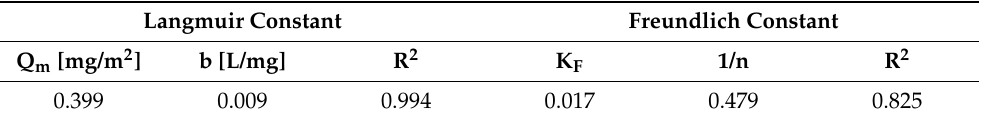
Table 1. Langmuir and Freundlich constants for the adsorption of picolinic acid onto the tungsten oxide